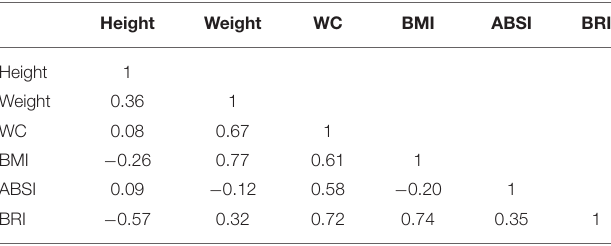
TABLE 2 | Pearson correlation coefficients between anthropometric indices of study participants a